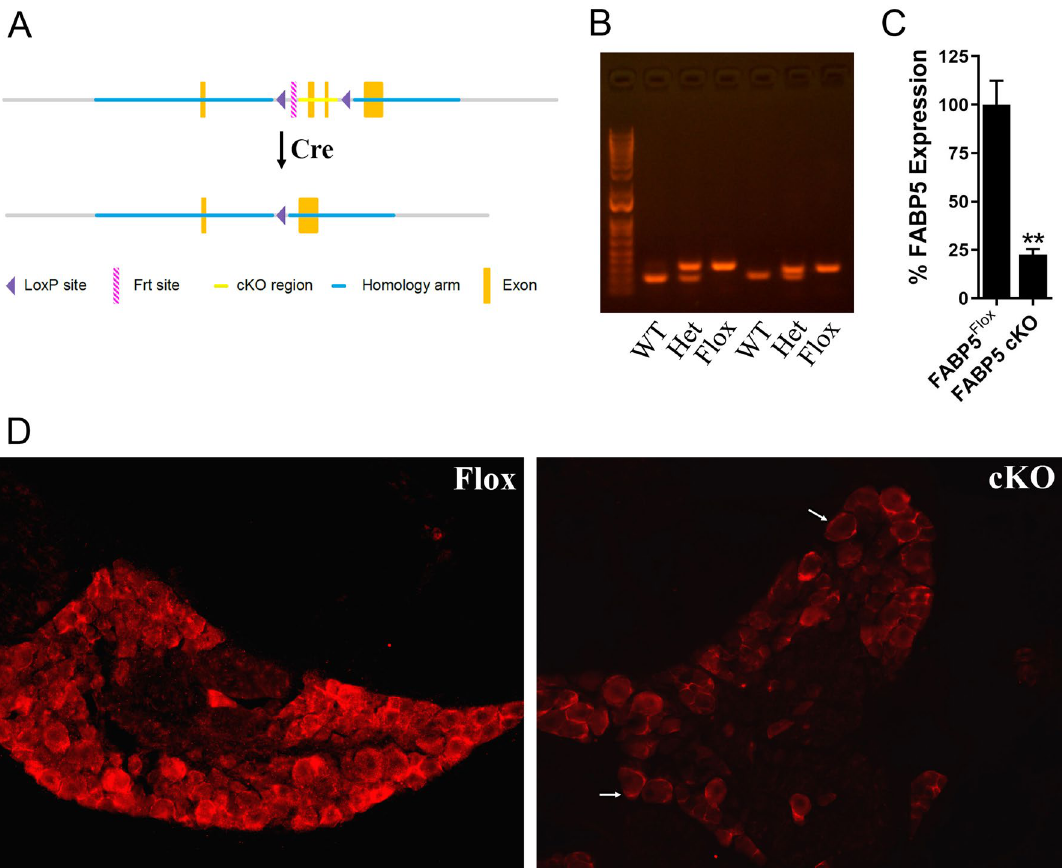
Figure 1. Characterization of FABP5 cKO mice. ( A ) Schematic showing the generation of FABP5 Flox mice and placement of LoxP sites. ( B ) PCR analysis of WT, heterozygous, and homozygous FABP5 Flox mice. ( C ) qPCR analysis of relative FABP5 expression in DRGs of FABP5 Flox and FABP5 cKO mice. ** p < 0.01 calculated using unpaired t test (n = 3). ( D ) FABP5 distribution in DRGs of FABP5 Flox and FABP5 cKO